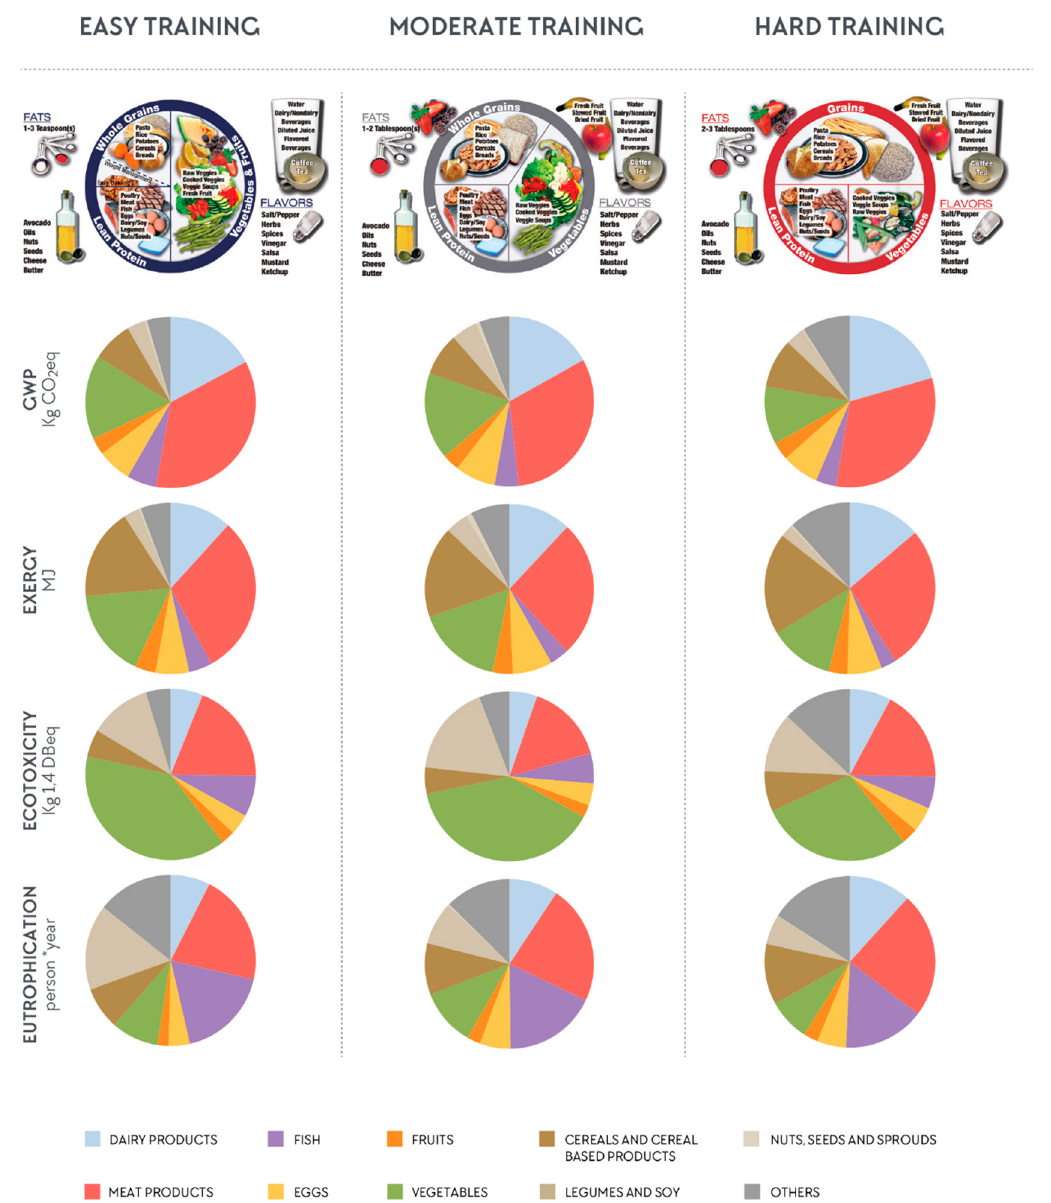
Figure 4. The contribution of each food group (aggregated) by training load and environmental impact category per plate. Figure 4 shows that meat and dairy contributed more to GWP and exergy, vegetables and legumes to ecotoxicity, and legumes and fish to eutrophication.